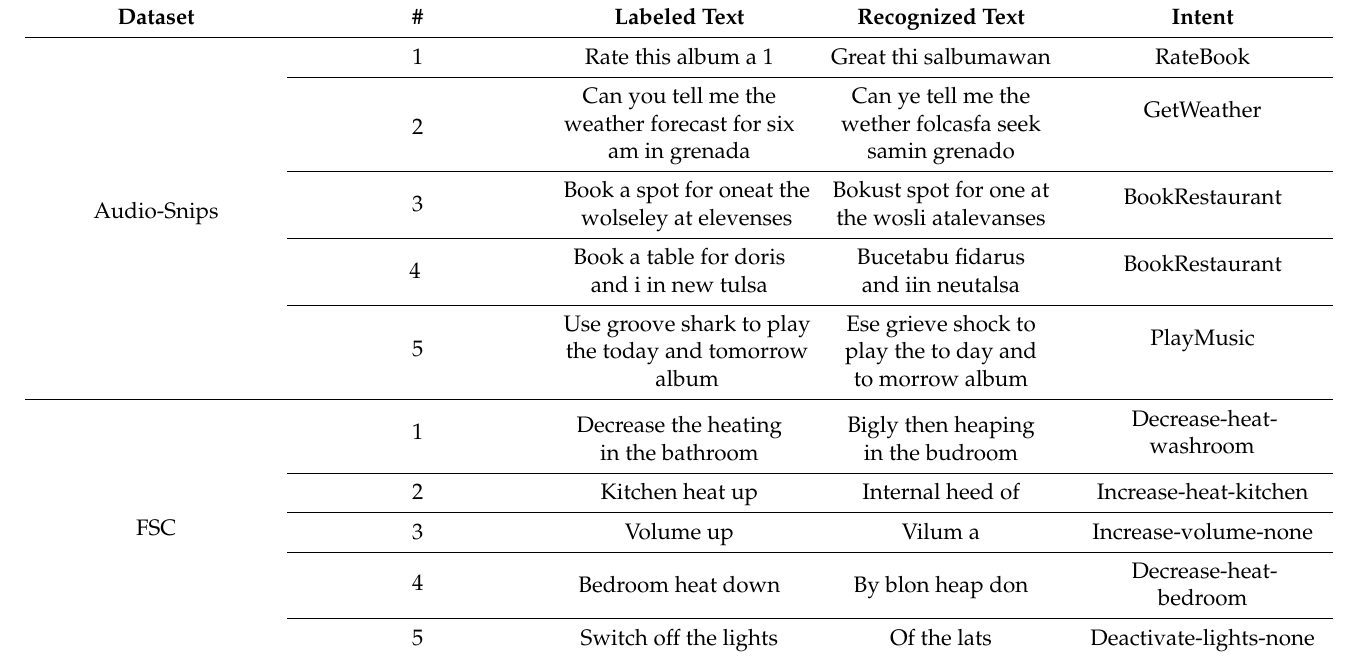
Table 2. Examples of the labeled text, the recognized text, and the intent label of the Audio-Snips and FSC dataset,